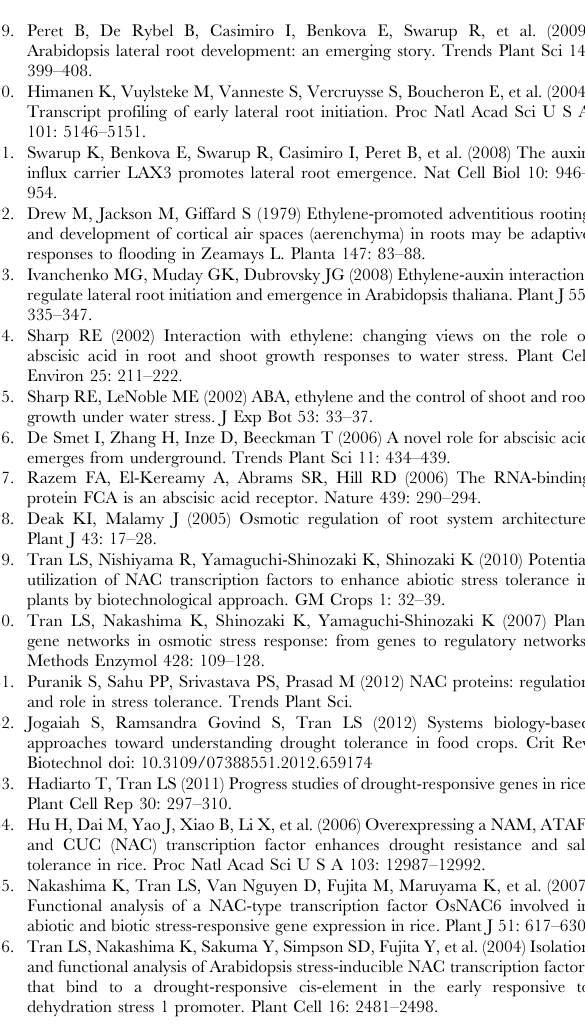
Table S1 Soybean W82 water stress treatments. For the water stress treatments, the plants were not supplied with water after they reached the V1 growth stage (14 days after sowing). Water-stressed tissues were collected when the stem water plants did not produce more leaves while the corresponding controls reached the V2, V3 and V6 growth stages, respectively. Table S2 Primers of reference genes, GmNAC003 and GmNAC004 used for qRT-PCR analysis in soybean and Arabidopsis